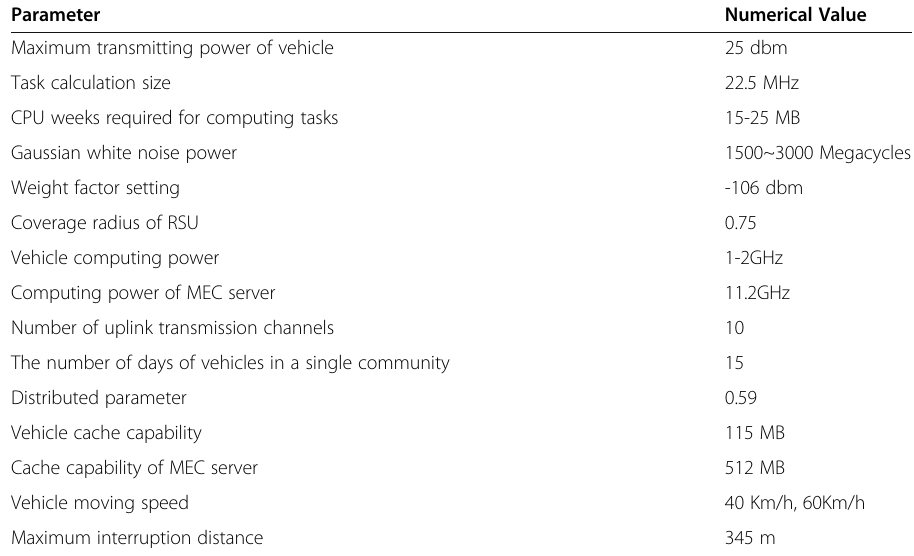
Table 1 Experimental simulation parameter